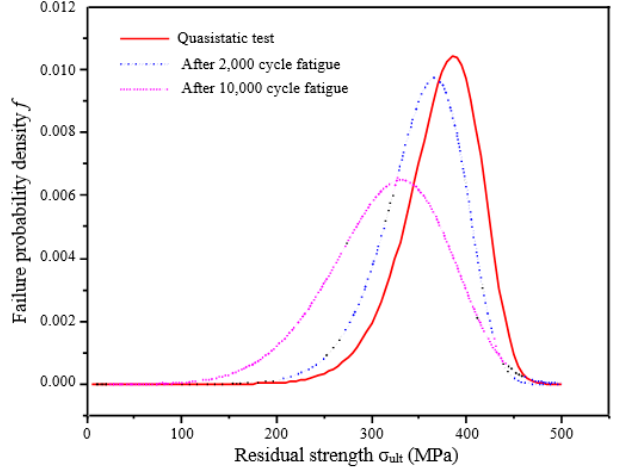
Figure 7. Variation of the failure probability density with the residual tensile strength. Table 2. Model parameters of the two-parameter Weibull distribution models based on maximum- likelihood estimation. No. of Samples